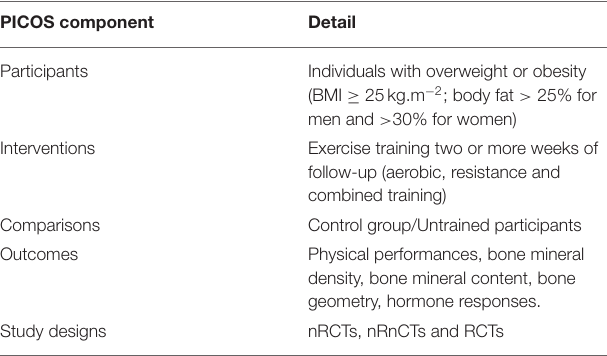
TABLE 1 | PICOS (participants, interventions, comparisons, outcomes, study design). PICOS